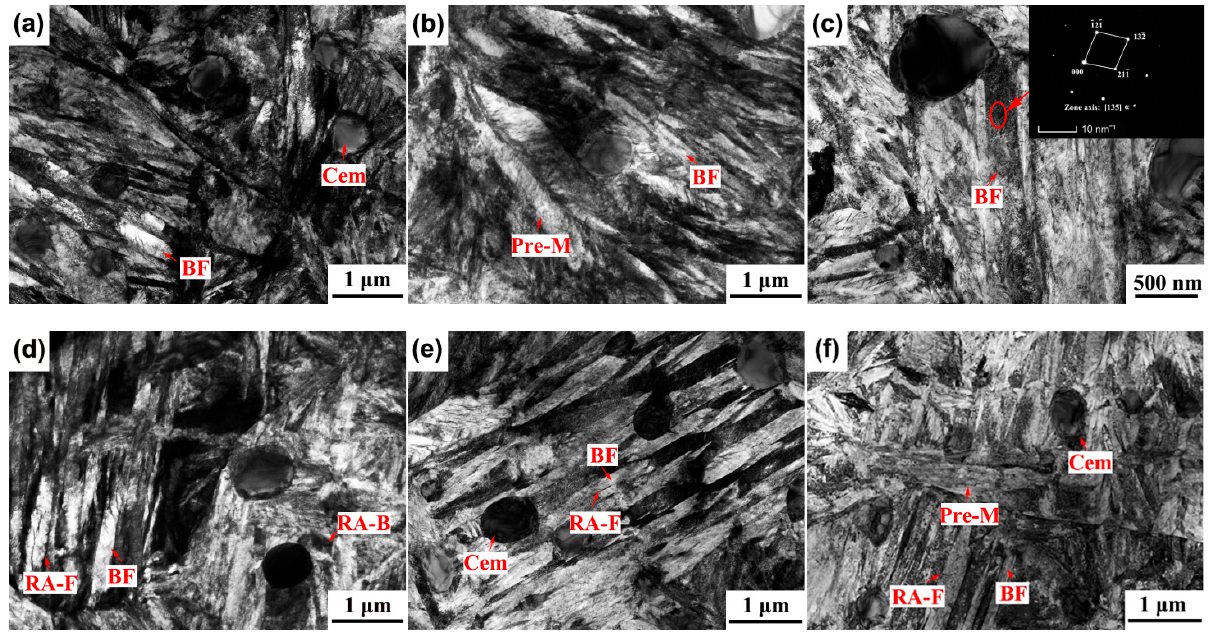
Figure 3. TEM images of specimens with different treatment processes: ( a ) 0 M, ( b ) 5 M, ( c ) 10 M, ( d ) 15 M, ( e ) 20 M, ( f ) 25 M.